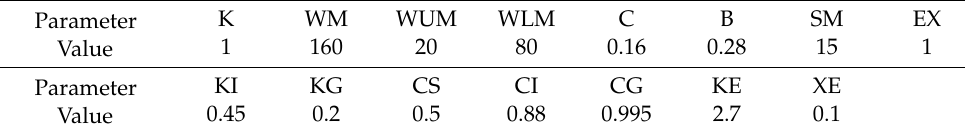
Table 2. Parameters of the Xin’anjiang model in the Anhua Reservoir catchment.